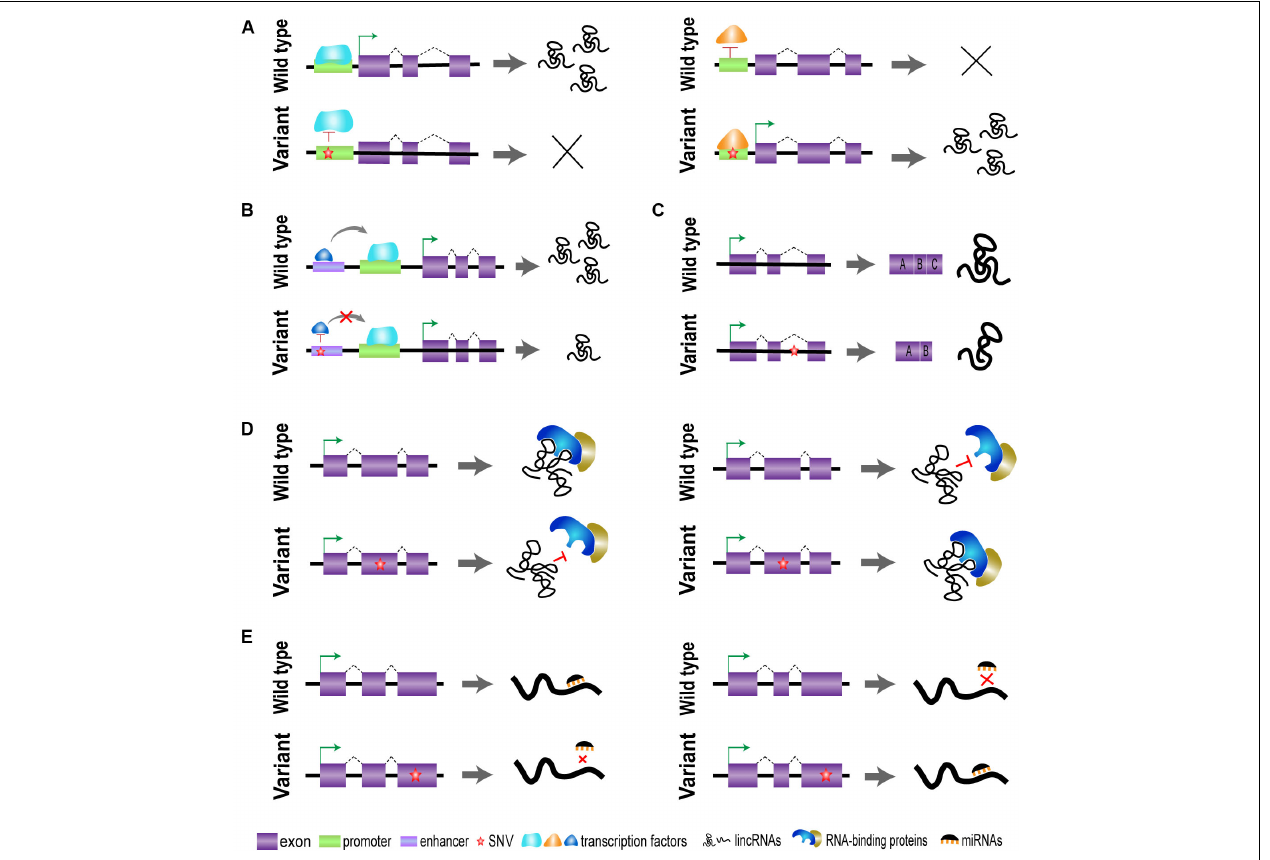
FIGURE 2 | Graphical representations of the driving effect of variants [single-nucleotide variants (SNVs)] on long intergenic non-protein coding RNA (lincRNA) regions. (A) Genetic variants located in promoter may affect the binding of transcription factors and regulate the transcription of lincRNAs. (B) Genetic variants on enhancer affect the binding of transcription co-regulators and regulate lincRNA expression. (C) Genetic variants on intron may affect the process of splicing and stability of lincRNA conformation. (D) Genetic variants located in exons affect the lincRNA secondary structure, lincRNA stability, and interactive function. (E) Genetic variants on exons may affect the sponging of microRNAs